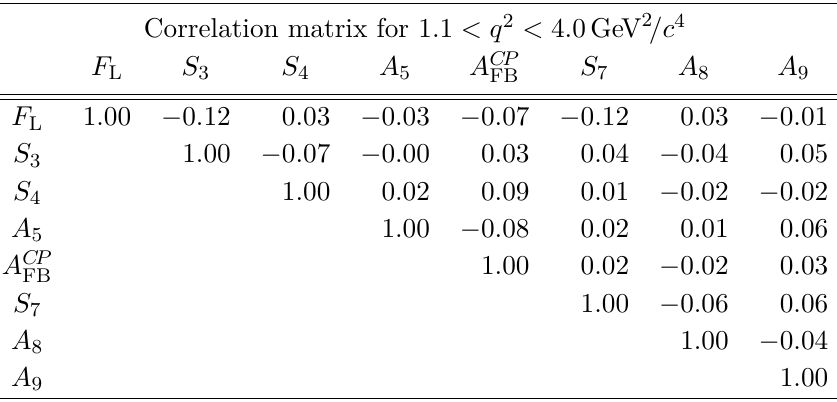
Table 3 . Correlation matrix for the q 2 regions 0 . 1 < q 2 < 0 . 98 GeV 2 /c 4 and 1 . 1 < q 2 < 4 . 0 GeV 2 /c 4